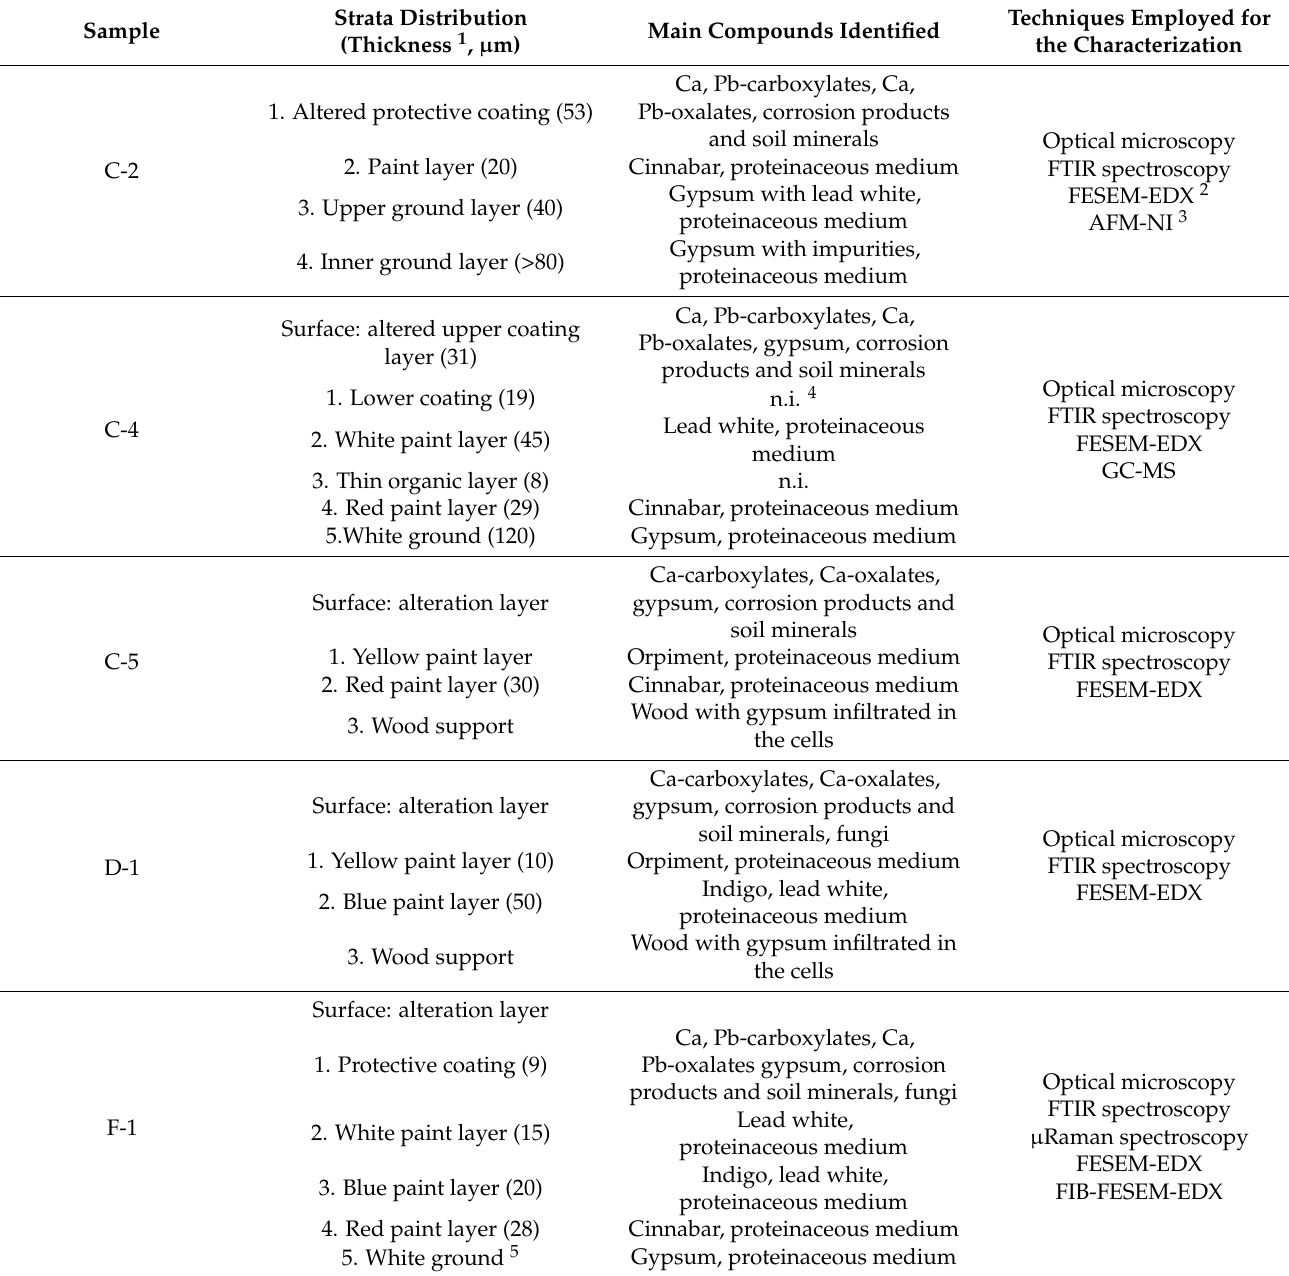
Table 1. Strata distribution and assignment of type of layer in the set of samples